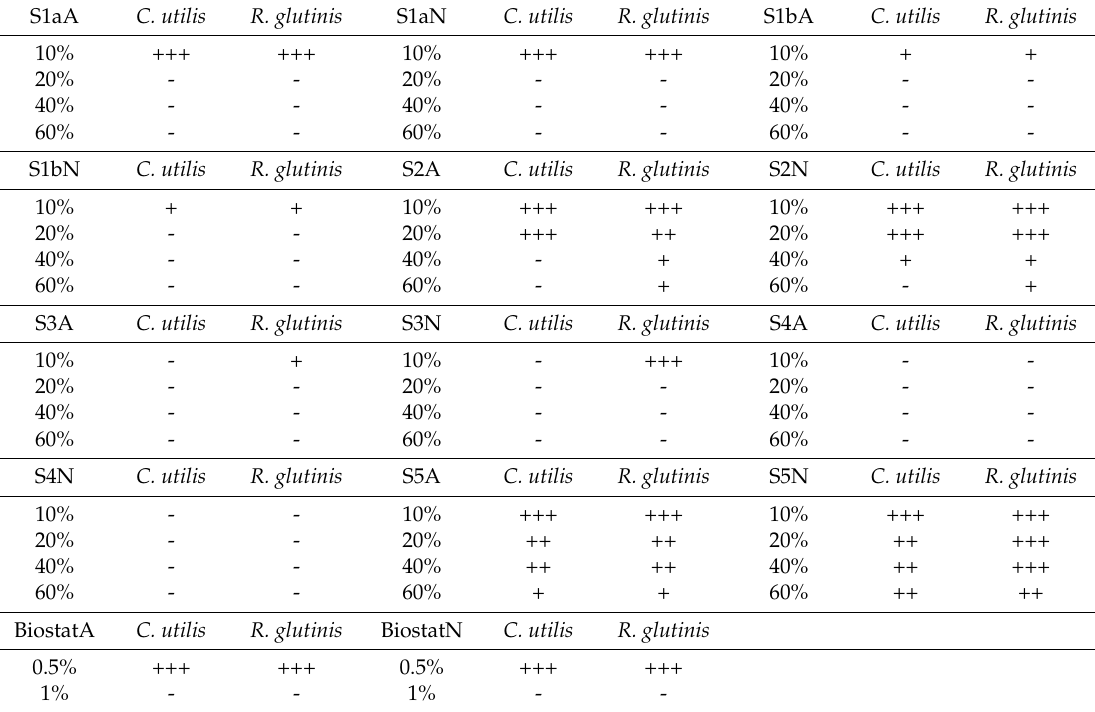
Table 4. Growth inhibition of selected yeasts by metallurgical